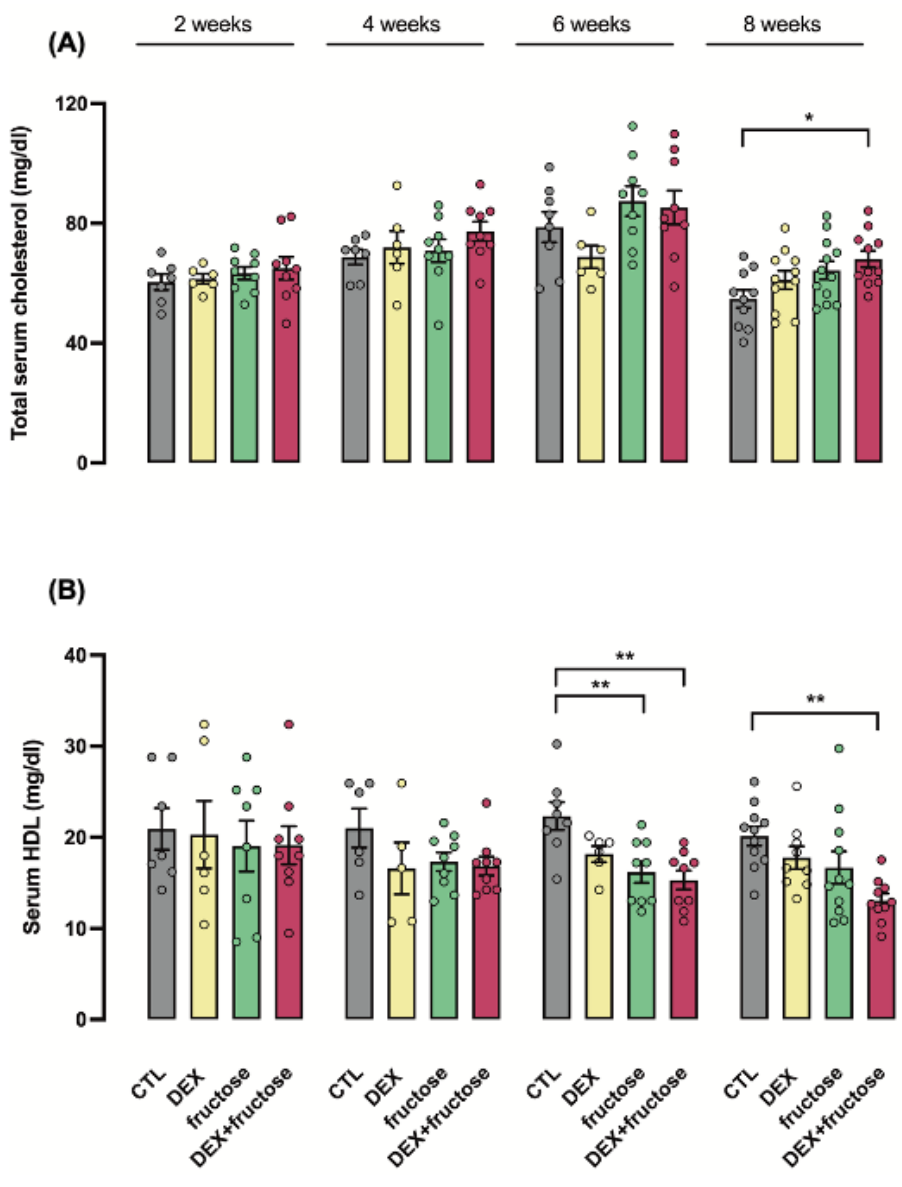
Figure 4. Time course of biochemical parameters (total cholesterol and HDL) in adult rats exposed or not to dexamethasone in utero. Blood samples of the four groups (described in Figure 3) were also used to measure total cholesterol ( A ) and high-density lipoprotein (HDL) ( B ). Data are presented as the mean ± SEM; * p < 0.05 and ** p < 0.01 vs. the group indicated by the bracket. n = 6 to 12 in ( A ) and ( B ).